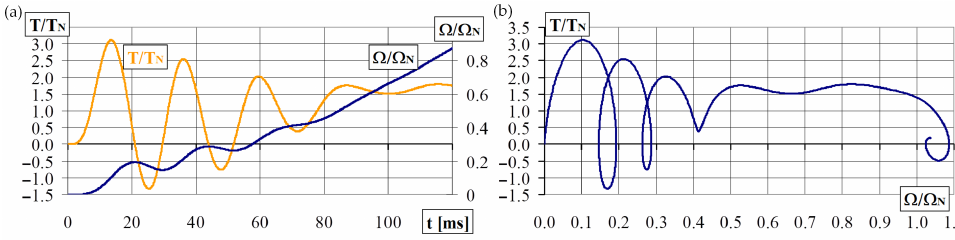
Figure 1. Waveform of electromagnetic torque and rotor speed ( a ), as well as mechanical dynamic characteristics ( b ) of a squirrel-cage induction motor during the classic direct starting.